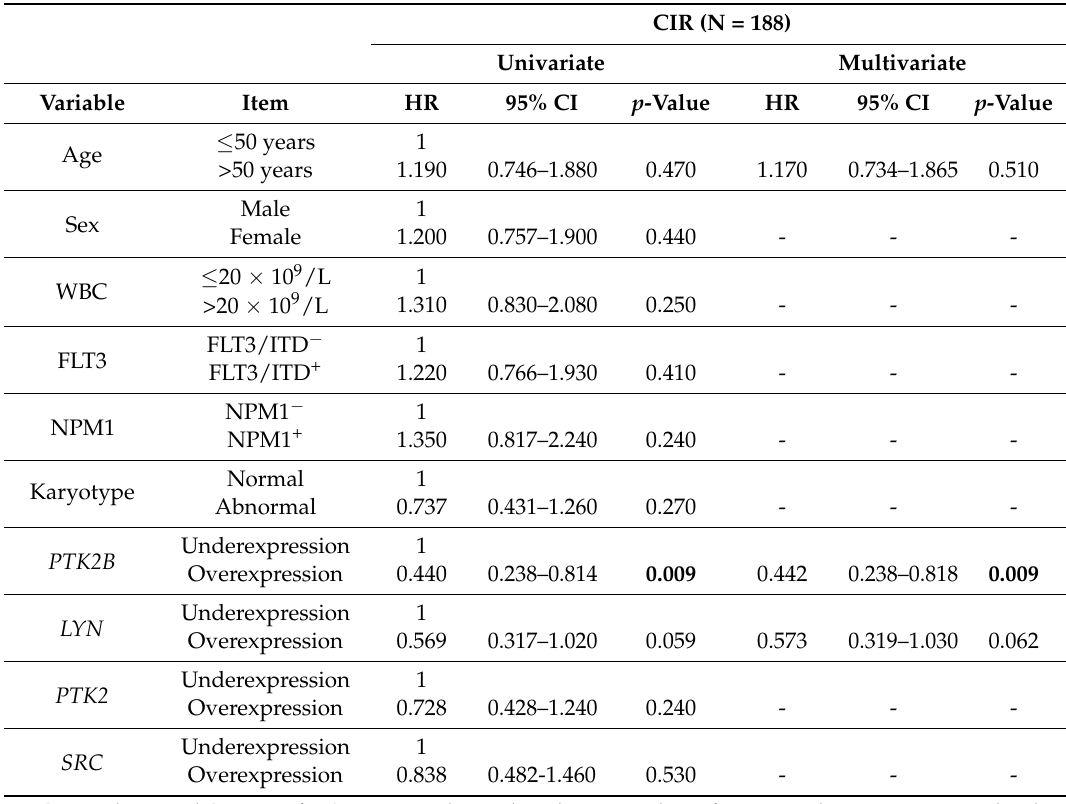
Table 5. Univariate and multivariate analyses of the association between relevant clinical variables and focal adhesion gene expression with CIR in patients with cytogenetic IR-AML and non-favorable FLT3/NPM1